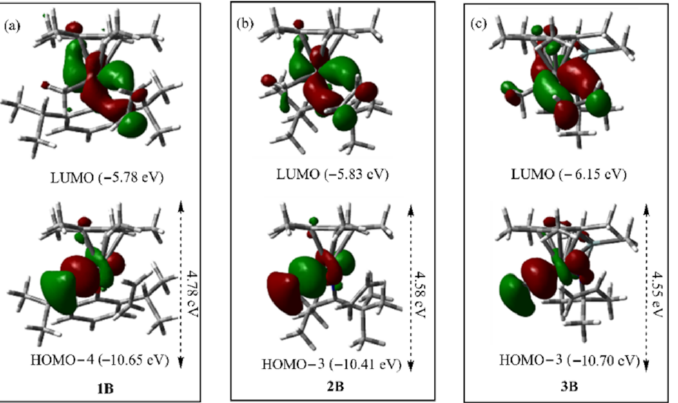
Figure 4. Important molecular orbitals at the intermediates 1B , 2B , and 3B : ( a ) LUMO and HOMO-4 molecular orbitals of 1B ; ( b ) LUMO and HOMO-3 molecular orbitals of 2B ; ( c ) LUMO and HOMO-3 molecular orbitals of 3B